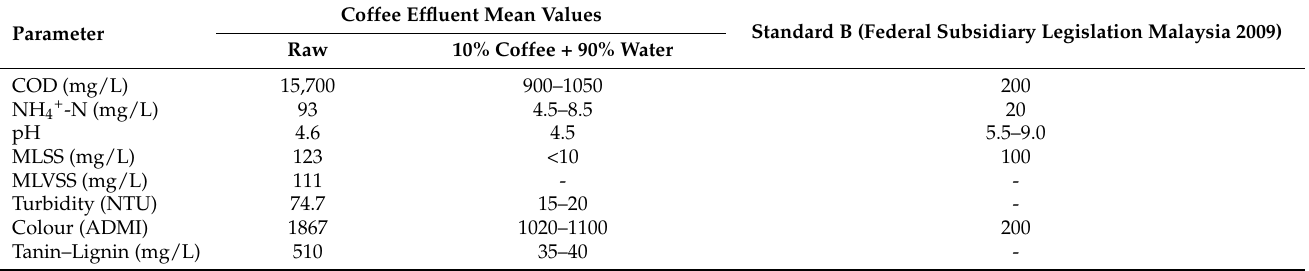
Table 1. Coffee effluent